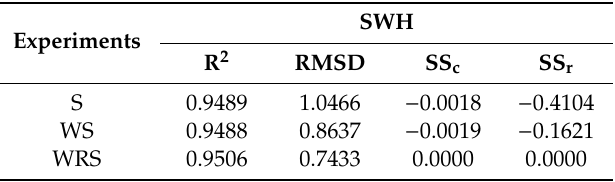
Table 5. Correlation coe ffi cients (R 2 ), root-mean-square errors (RMSD) and skill scores (SS c and SS r ) for significant wave height from the di ff erent